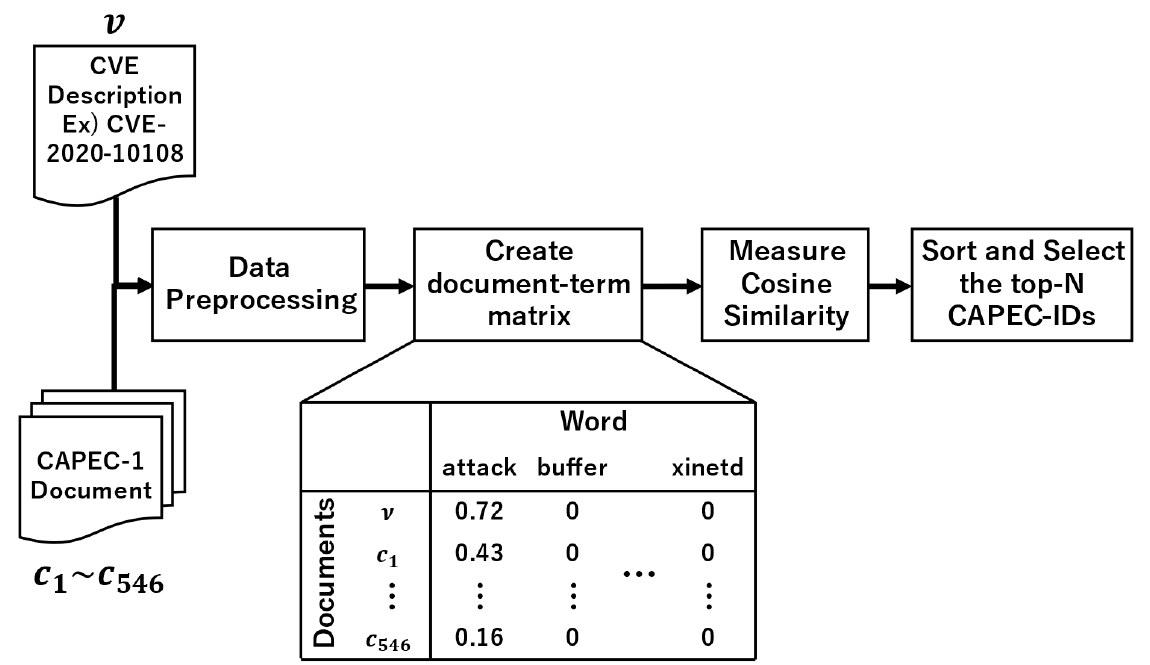
Figure 4. Overview of the tracing based on the TF-IDF algorithm.